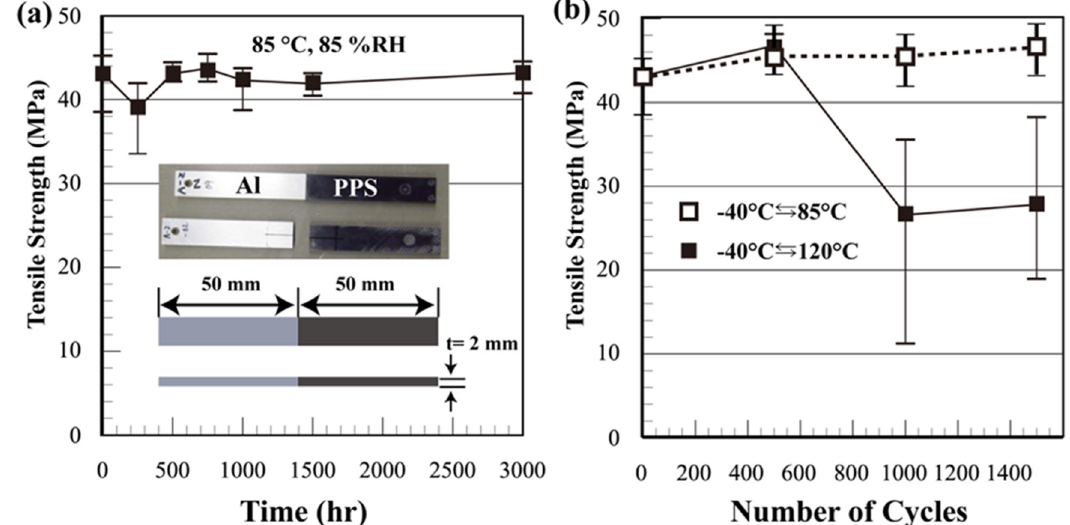
Fig. 9. Changes in the PPS/Al5052 tensile joint strength under accelerated environmental conditions. (a) High humidity and high temperature durability at 85 ° C and 85% RH. The butt-joint test specimens before and after the test are shown therein. (b) Thermal shock resistivity under the conditions from (cid:3) 40 to 85 ° C and from (cid:3) 40 to 120 ° C. Each data is shown as the average of 5 tests with maximum and minimum results.